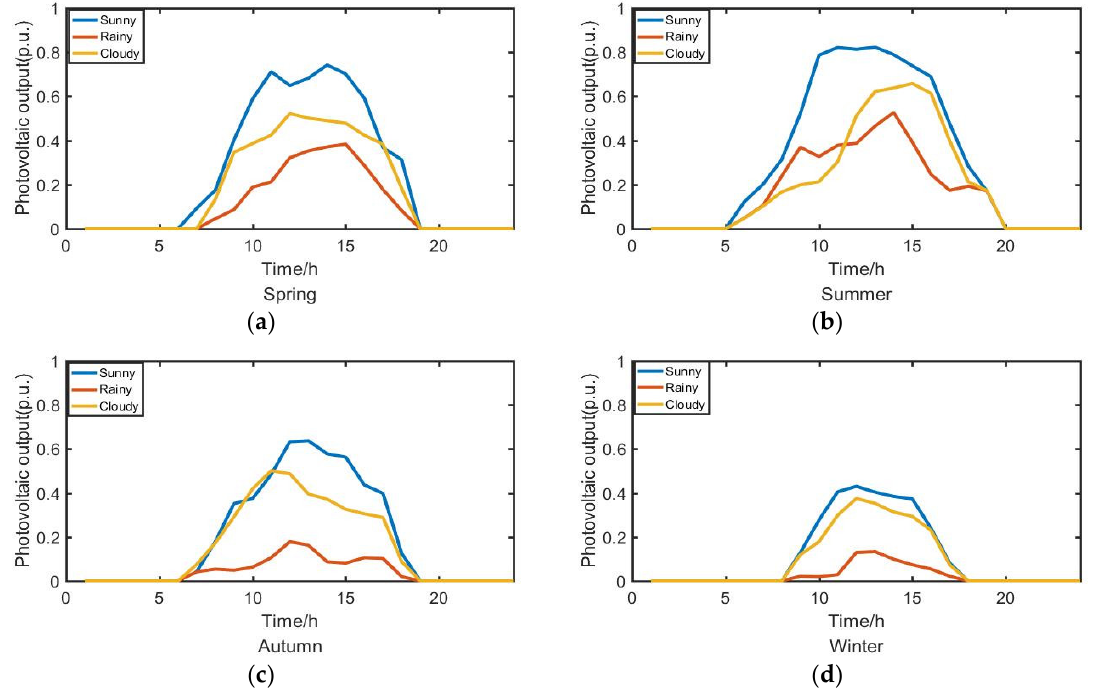
Figure 4. PV fluctuation curve: ( a ) PV fluctuation curve in spring; ( b ) PV fluctuation curve in summer; ( c ) PV fluctuation curve in autumn; ( d ) PV fluctuation curve in winter.